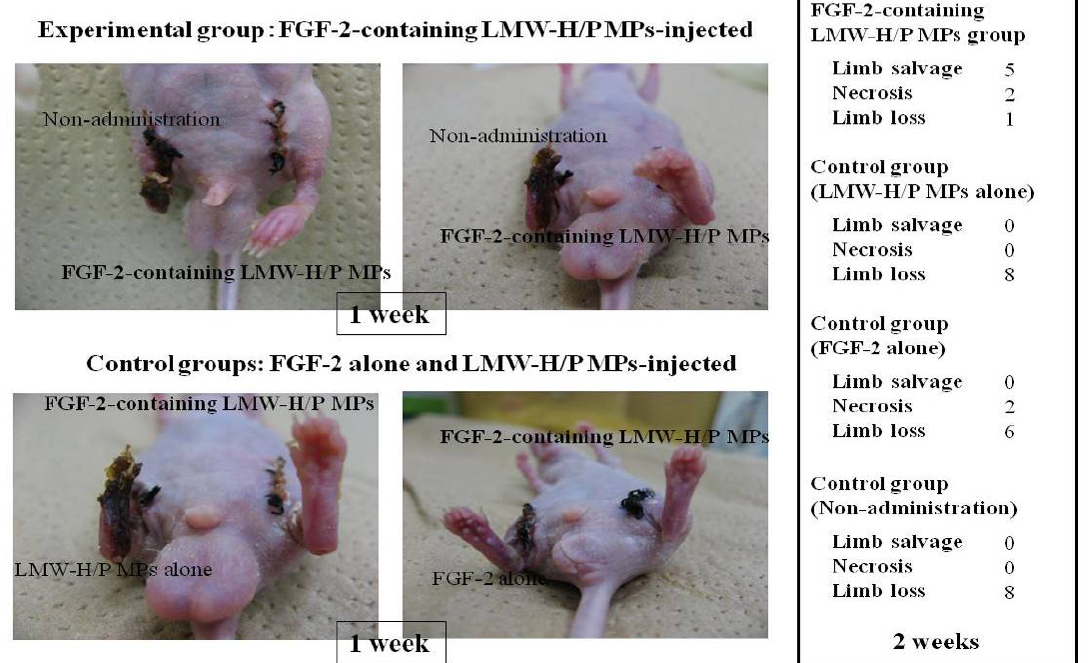
Figure 2. Prevention of limb loss in hindlimb Ischemic model by FGF-2-containing LMW-H/P